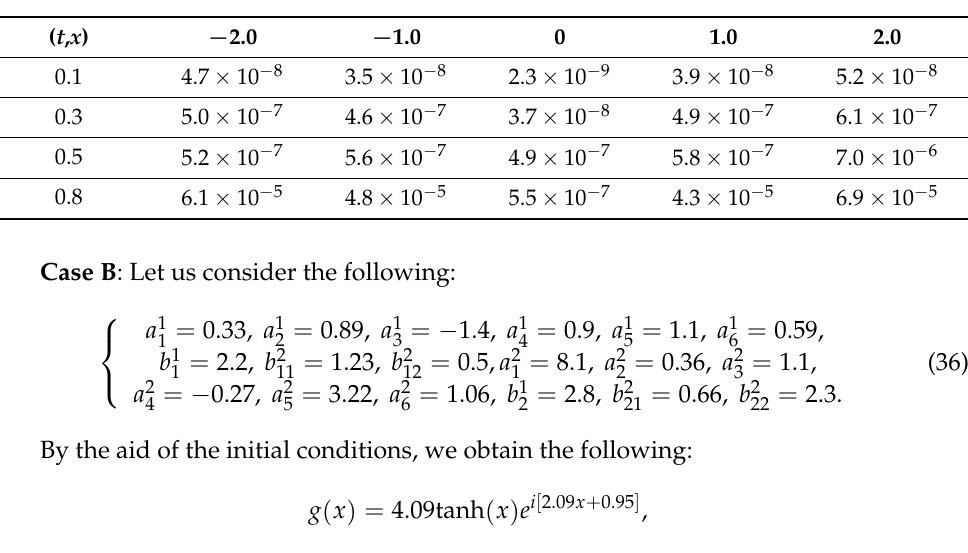
Figure 1. ( Above ) Three-dimensional illustrations of the numerical simulation and exact solution, and two-dimensional illustration of the approximation of | u | 2 ; ( Below ) three-dimensional illustrations of the numerical simulation and exact solution, and two-dimensional illustration of the approximation of | v | 2 for Case A. Table 1. Case A: Absolute error for different values of ( x , t ) considering N = 15